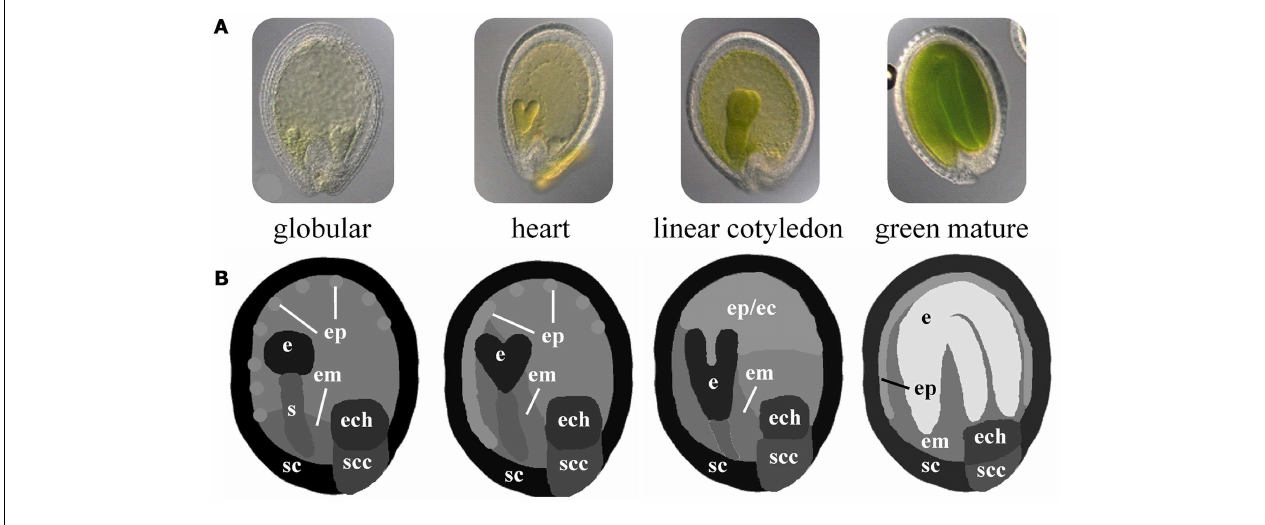
stages which have been used for integration of transcriptome data. (e, embryo; s, suspensor; em, endosperm micropylar; ep, endosperm peripheral; ec, endosperm cellularized; ech, endosperm chalazal; sc, seed coat; scc, seed coat